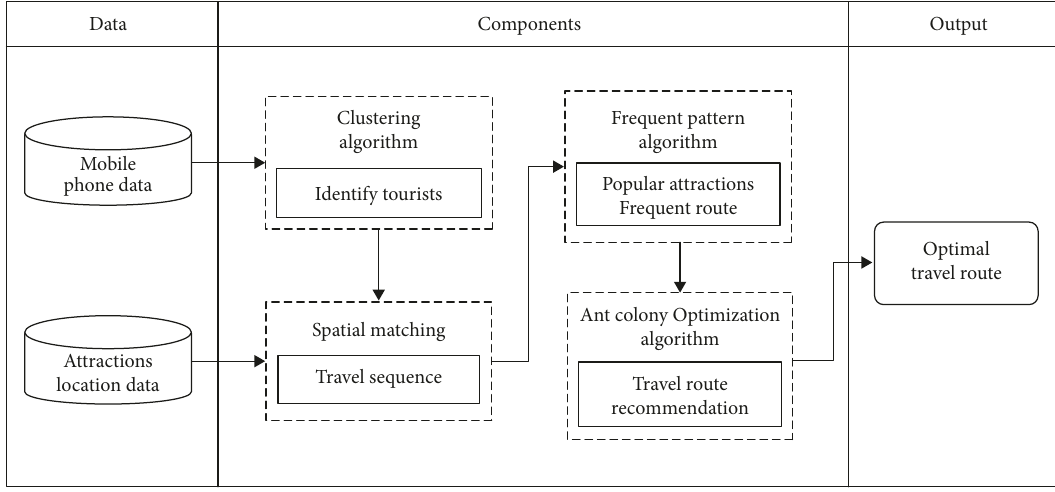
Figure 1: The research